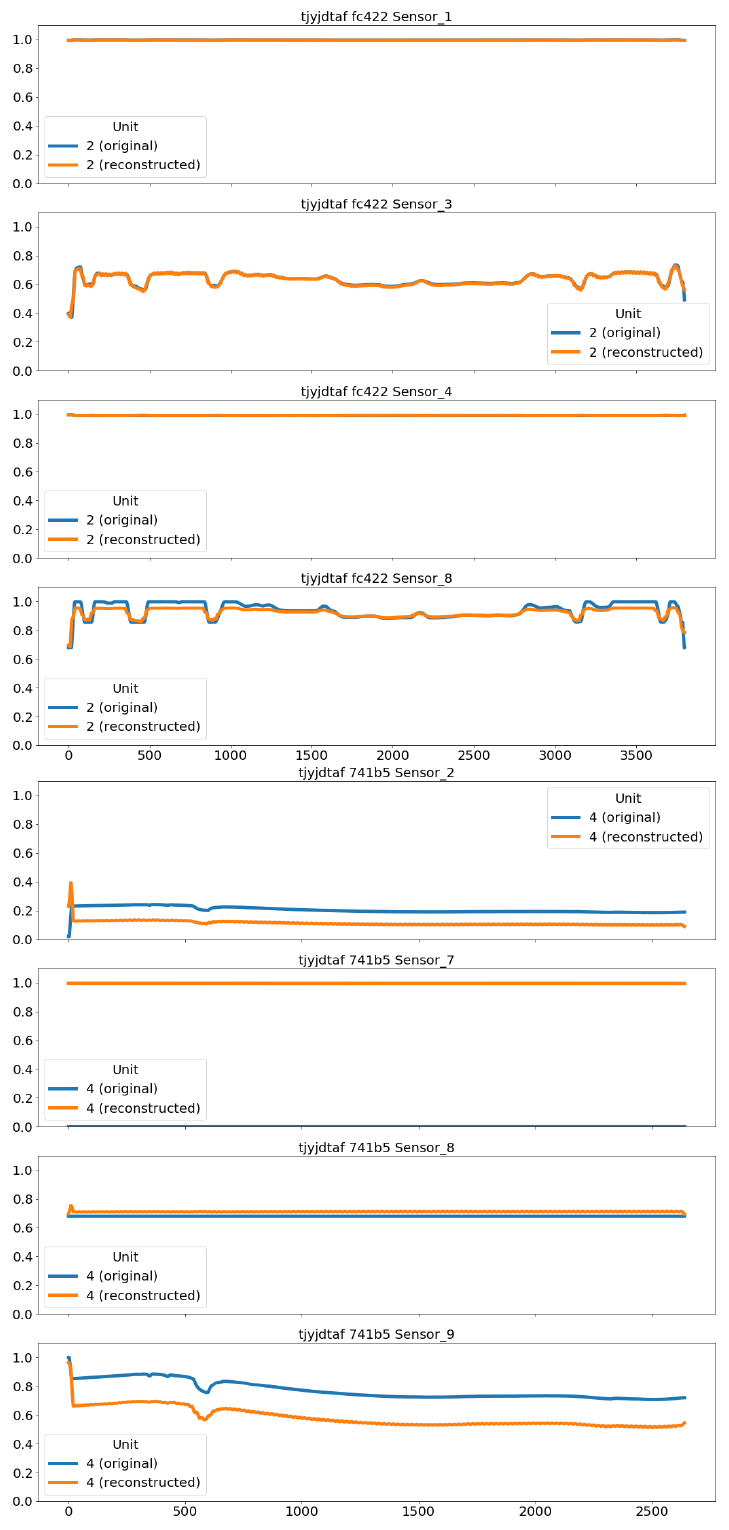
Figure 12. Signal reconstruction examples with a FCAE of two flights from tail tjyjdtaf . On the left, good reconstruction for a healthy cooling unit. On the right, bad reconstruction for a faulty cooling